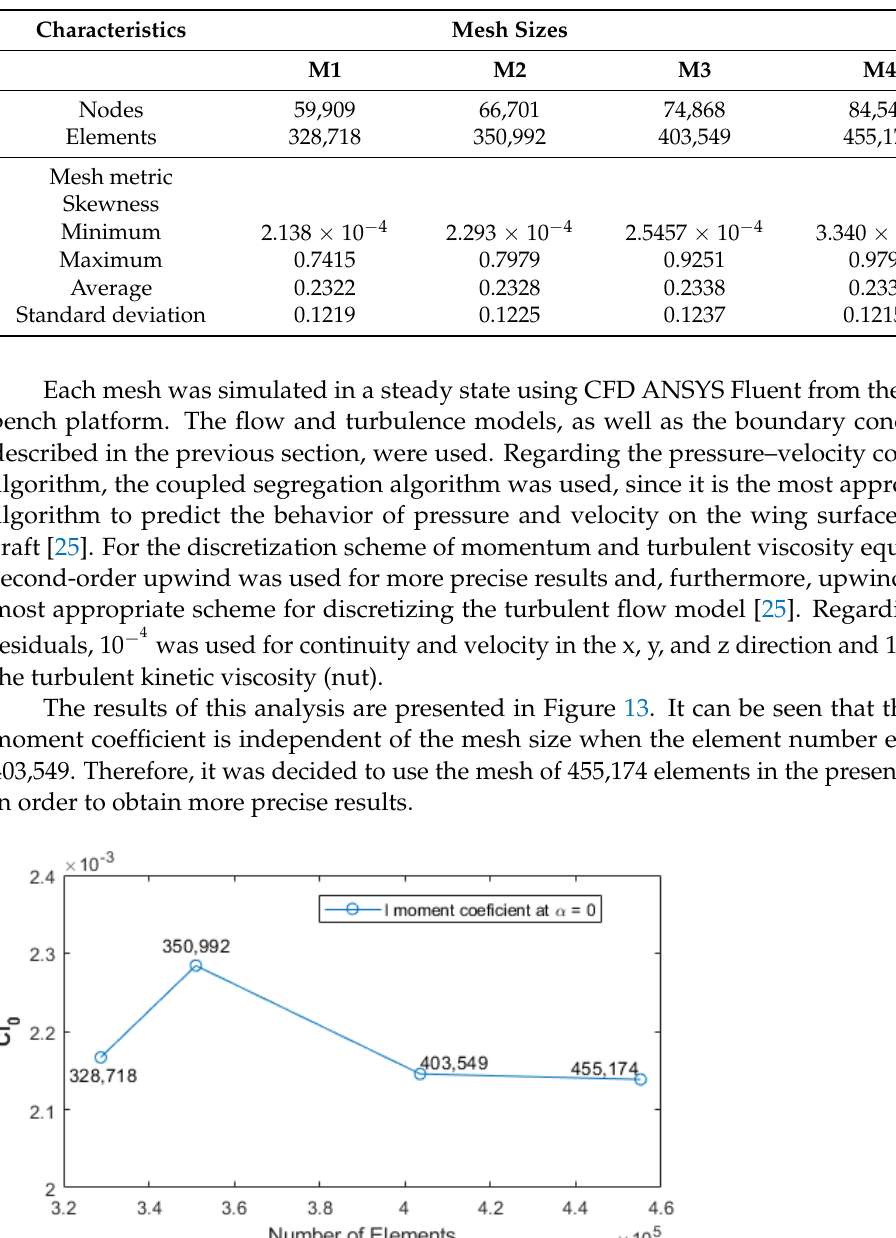
Table 7. Statistics in the study of mesh independence.